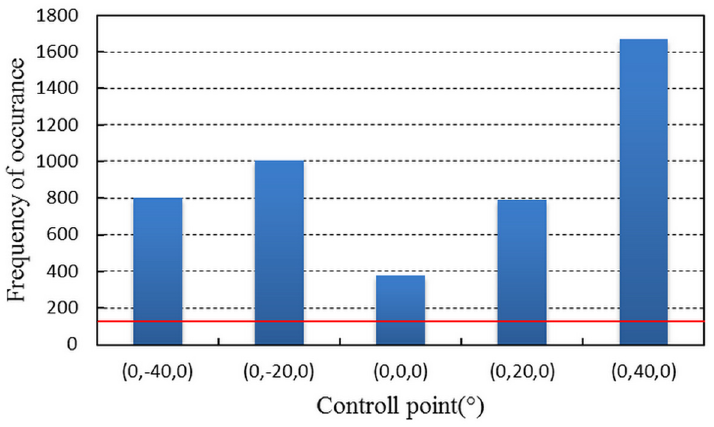
Fig 10. The frequency of occurrence of M I . Only the filtered control points are displayed. The red line is the cutoff frequency.